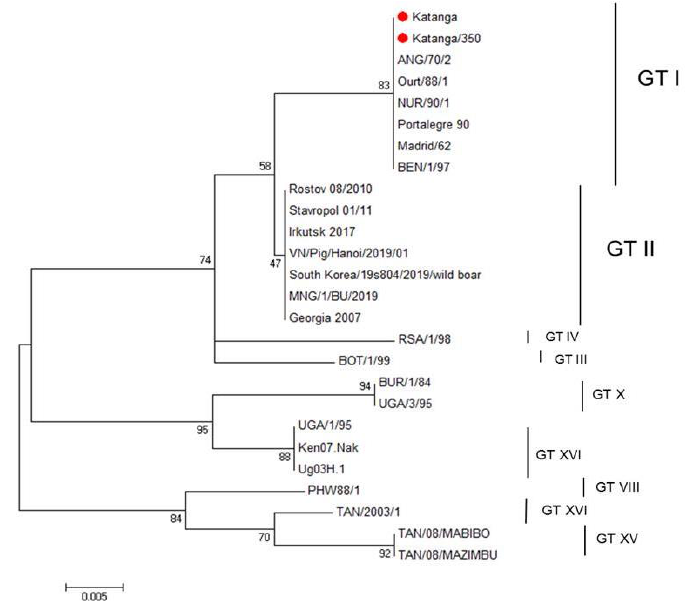
Figure 1. Maximum likelihood tree of ASFV B464L gene sequences (1000 bootstrapping replicates). Genotype status is indicated (GT#). The ASFV strains, Katanga and Katanga-350, are indicated with a red circle.